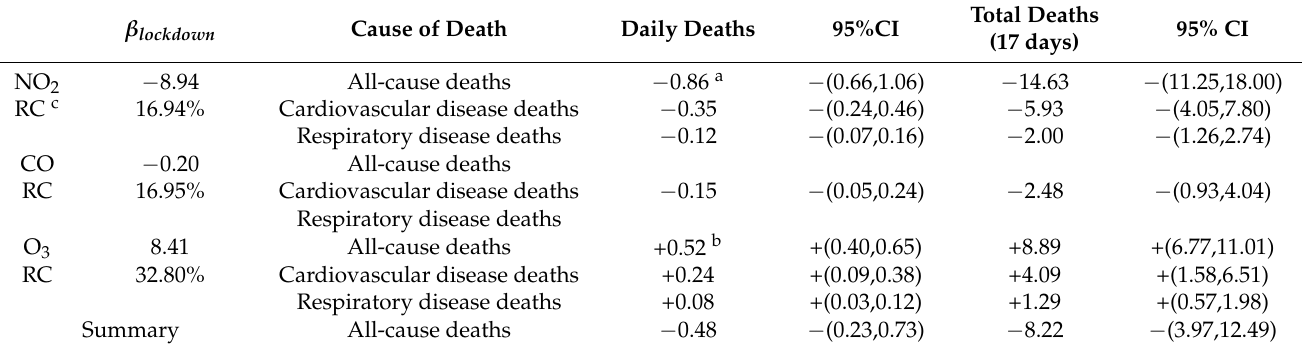
Figure 1. Time-series concentrations of air pollution in Shijiazhuang and Baoding. The solid black verticals are associated with the date of implementation of the lockdown policy. Table 4. Number of deaths due to air pollutants change during the